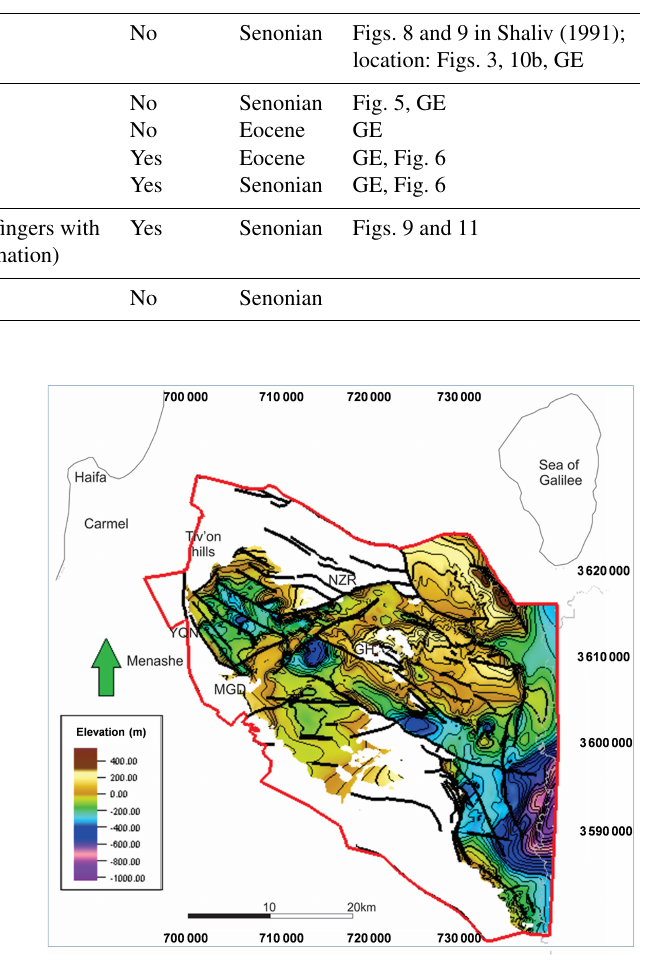
Figure 6. Location of the Lower Basalt Formation and Hordos For-